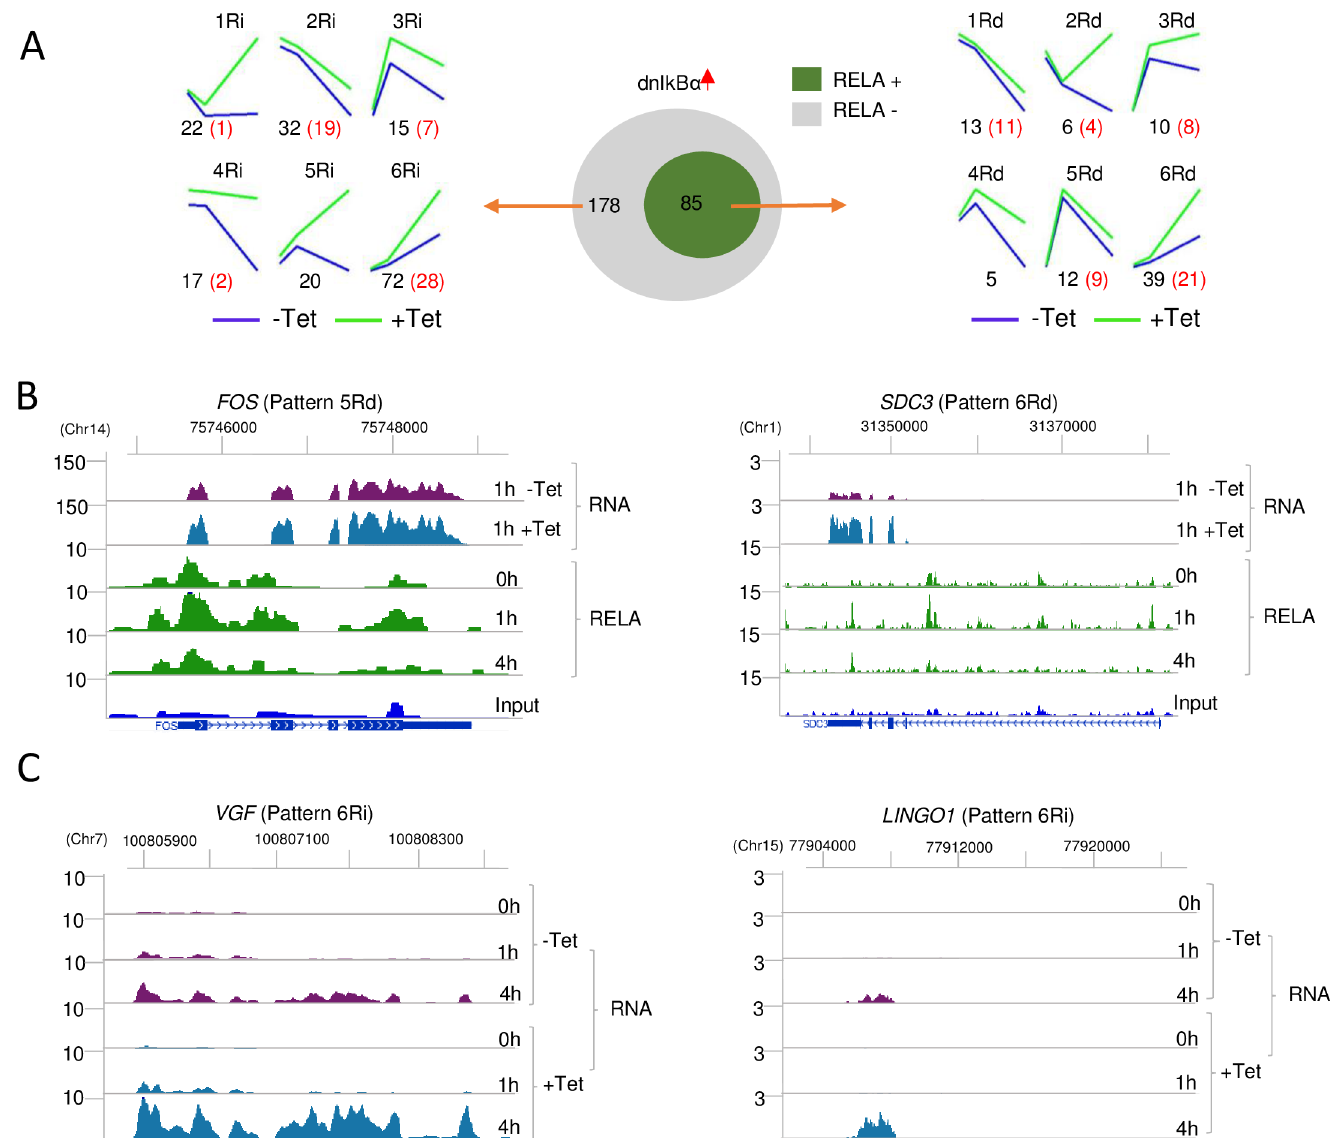
Fig 4. Repression of gene expression by NF- κ B. Genes whose expression was increased by dnI κ B α in both Tet-responsive clones were identified by RNA-Seq. (A) Genes that bound RELA (middle, green) and their time-dependent expression patterns in the absence (blue) or presence (green) of Tet-induced dnI κ B α are shown on the right. See also S4A Fig. The letters “Rd” after a pattern number indicate genes that were down-regulated by RELA binding, and the letters “Ri” indicate genes whose down-regulation was RELA dependent but did not bind RELA. Numbers of genes in each category are shown in black below the graphs. Red numbers correspond to genes whose expression changed more than 2-fold in the absence of Tet. Expression patterns of 178 dnI κ B α -up-regulated genes that did not bind RELA (middle, gray) are shown on the left, with numbers and color coding as described above. (B) Representative examples of dnI κ B α -up-regulated genes that bind RELA. Top 2 tracks show RNA-Seq tracks in the presence or absence of Tet-induced dnI κ B α at the time of maximal RNA expression; the y axis denotes normalized reads per million. Complete time courses for each gene are provided in S4B Fig. The bottom part shows RELA ChIP-Seq tracks over the entire time course in activated BJAB cells. Genomic organization and transcription orientation (arrows) are shown below the input DNA track. Numbers above the tracks refer to gene location in hg19. The y axis denotes normalized reads per 10 million. (C) Representative examples of dnI κ B α -up-regulated genes that do not bind RELA. These genes are proposed to be modulated by RELA-responsive factors (see text). RNA-Seq tracks over the complete activation time course in the absence (-Tet) or presence (+Tet) of dnI κ B α are shown. Genome scale datasets are available on the GEO website (http://www.ncbi.nlm.nih.gov/geo/) (Accession number GSE117259). ChIP-Seq, chromatin immunoprecipitation and sequencing; dnI κ B α ,dominant negative NFKB inhibitor alpha; GEO, Gene Expression Omnibus; NF- κ B, nuclear factor kappa B; RNA-Seq, RNA sequencing; Tet, tetracycline.